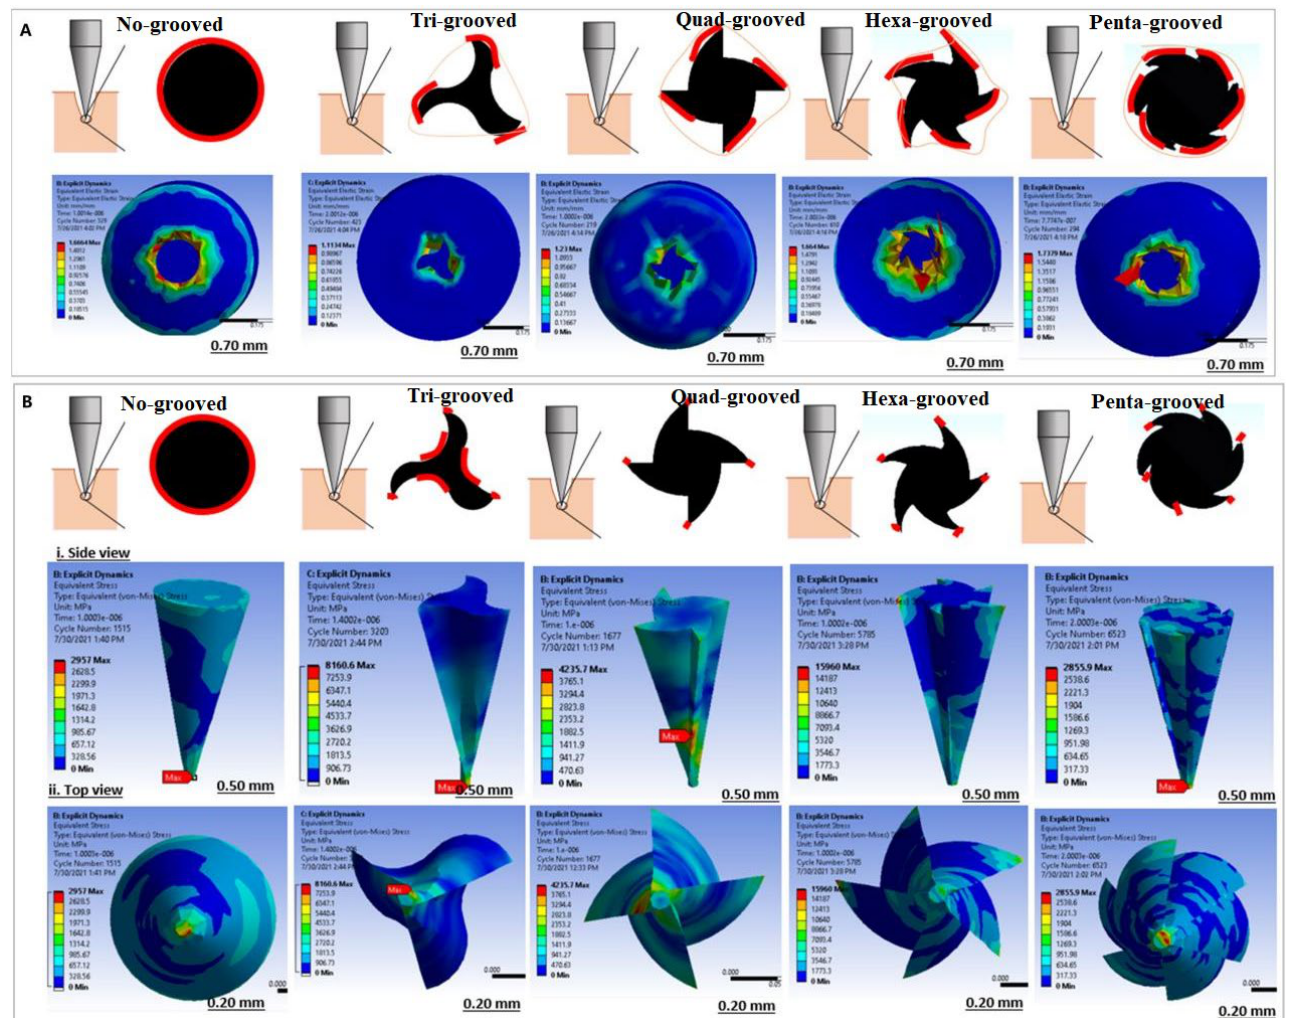
Figure 5. Strain ( A ) and Stress; ( B ) distribution of variable outer-grooved design (Reprinted with permission from Ref. [60]. Copyright 2021, Elsevier).